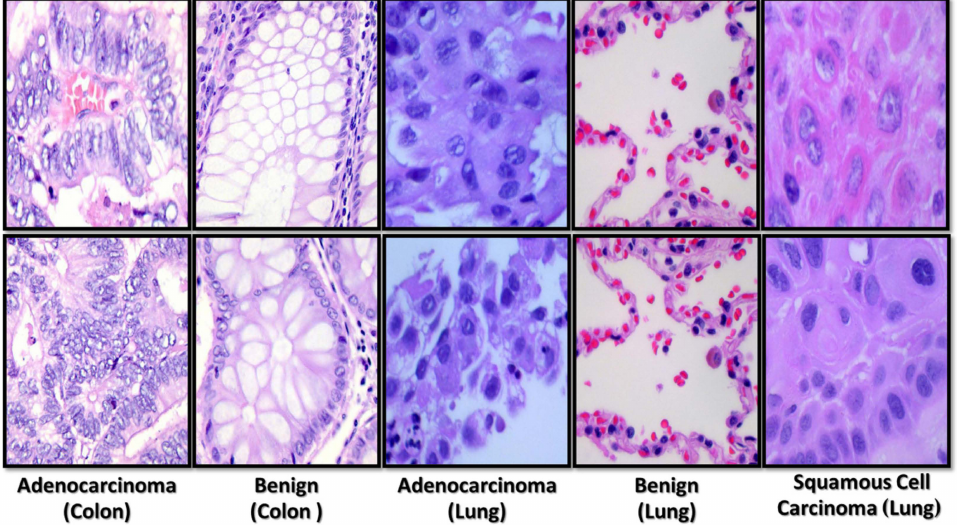
Figure 1. Some examples of histopathological images from the used